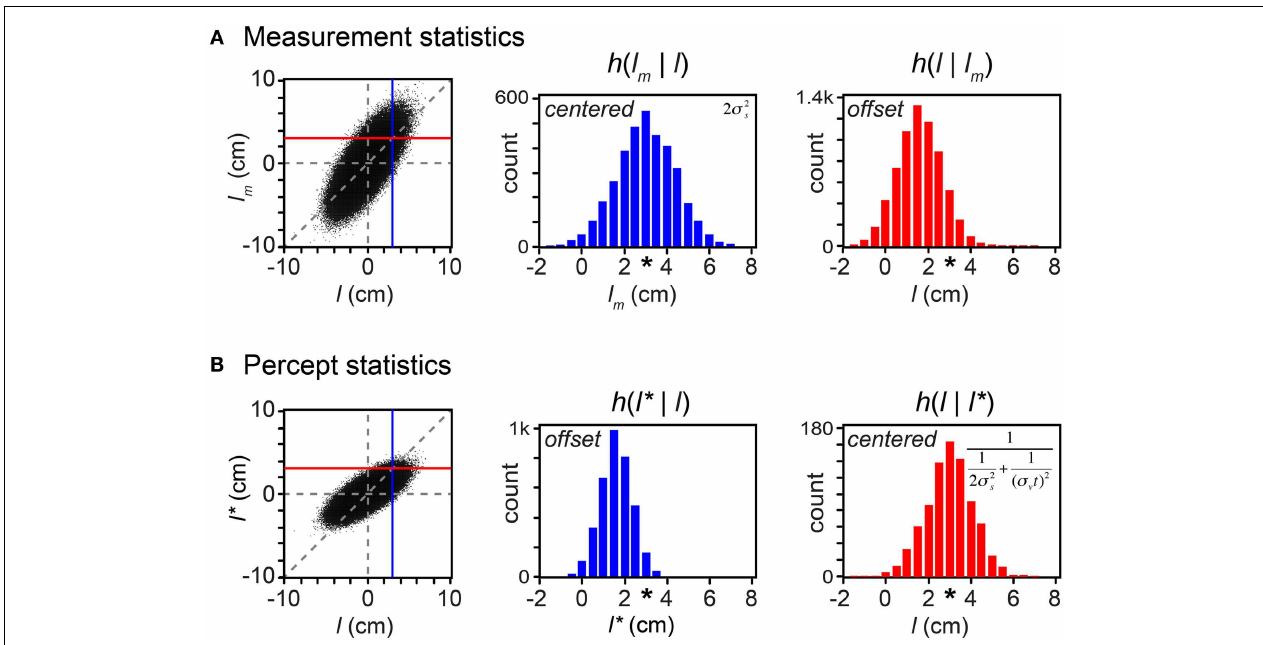
samples that fell along the blue vertical line in the scatterplot).The histogram is a Gaussian distribution centered at l m = 3cm (asterisk). Right : histogram of l values of trajectories that gave rise to l m between 2.95 and 3.05cm (i.e., l samples that fell along the red horizontal line in the scatterplot).The histogram represents the observer’s posterior density over l . It is a Gaussian distribution centered at l = 1.6cm, not 3cm (asterisk). (B) Left, center, and right panels as in (A) , but for l * rather than l m . Center : l * is a biased estimator. Right : on trials in which the observer perceived l * = 3cm, the true trajectory length averaged 3cm. Because the perceived length is a deterministic function of the measurement, this histogram has the same variance as the posterior density over l . Inset formulas in (A) center and (B) right show the variances of these histograms (See “One-dimensional reductions” in Appendix).These are equal to the mean-squared error between each estimator and the true